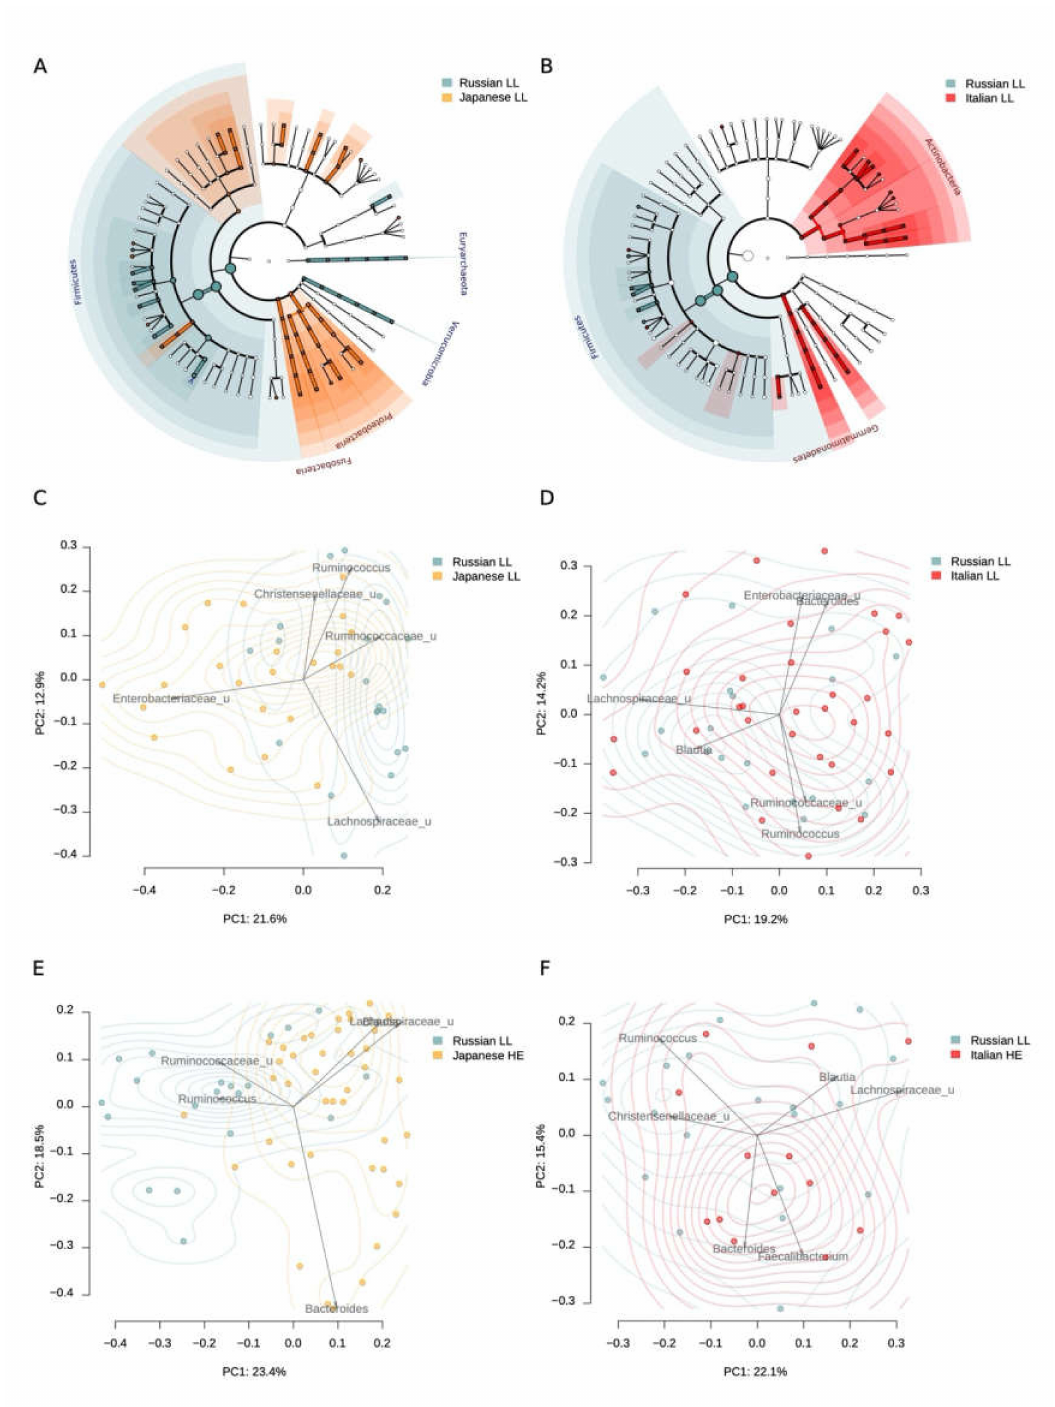
Figure 2. Gut microbiome di ff erences between the long-livers from Russia and the long-livers and healthy adults from external datasets: Italian and Japanese. A, B—Generalized visualization of the di ff erences in the individual taxa abundance at di ff erent taxonomic levels between the Russian and Japanese long-livers ( A ), and the Russian and Italian long-livers ( B ). Significant di ff erences in the phylum level are marked with labels. C, D—Comparison of the long-livers’ microbiome community from Russian ( n = 20) and Japanese ( n = 24) cohorts ( C ) and the Russian ( n = 20) and Italian ( n = 32) cohorts ( D ) using PcoA analysis with Bray–Curtis dissimilarity metric. E, F—Comparison of Russian long-livers’ ( n = 20) microbiome community with that of Japanese ( n = 24) ( E ) and Italian ( F ) ( n = 32) healthy